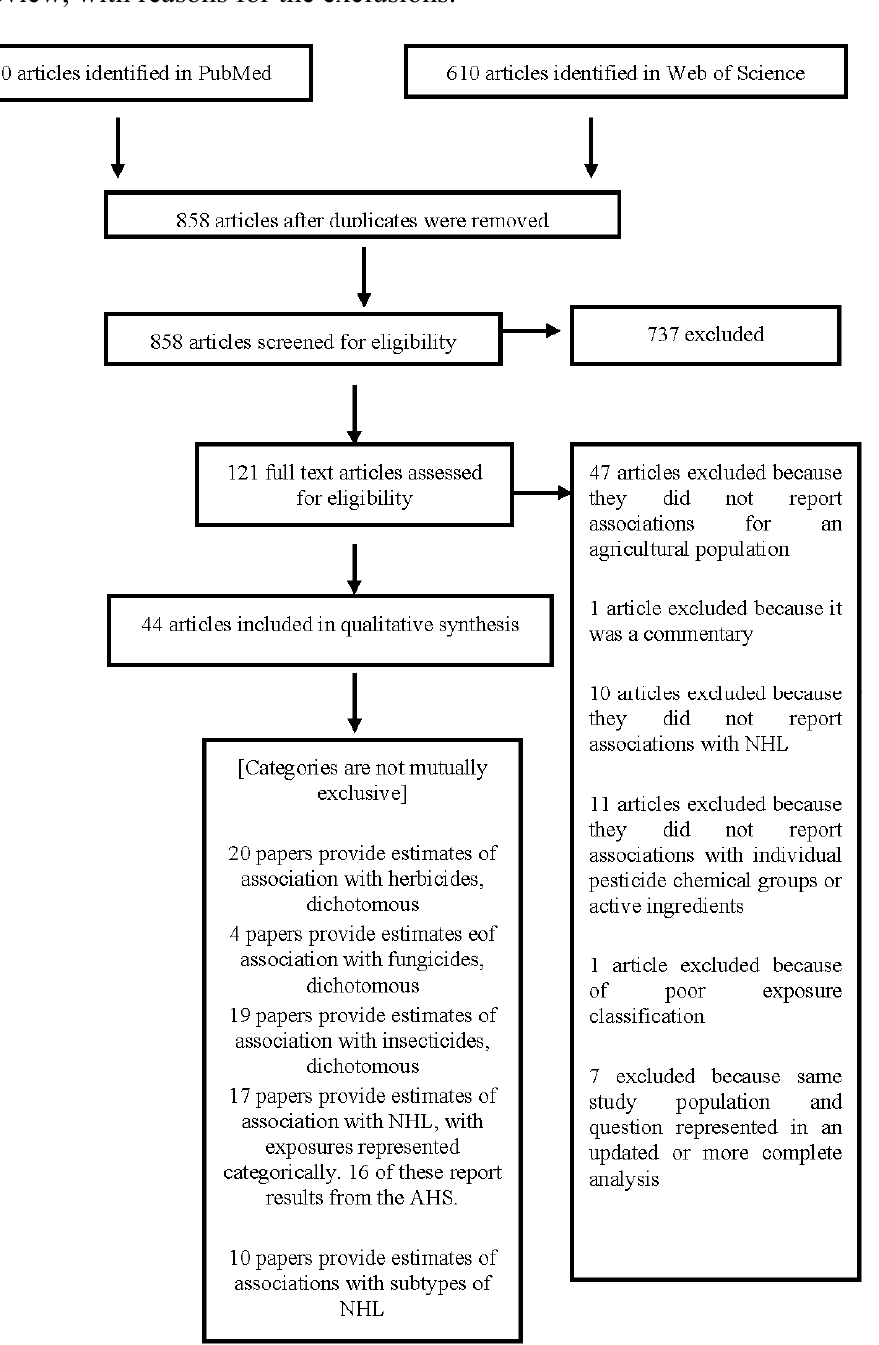
Figure 1. Flow chart showing the articles that were included and excluded in the systematic review, with reasons for the